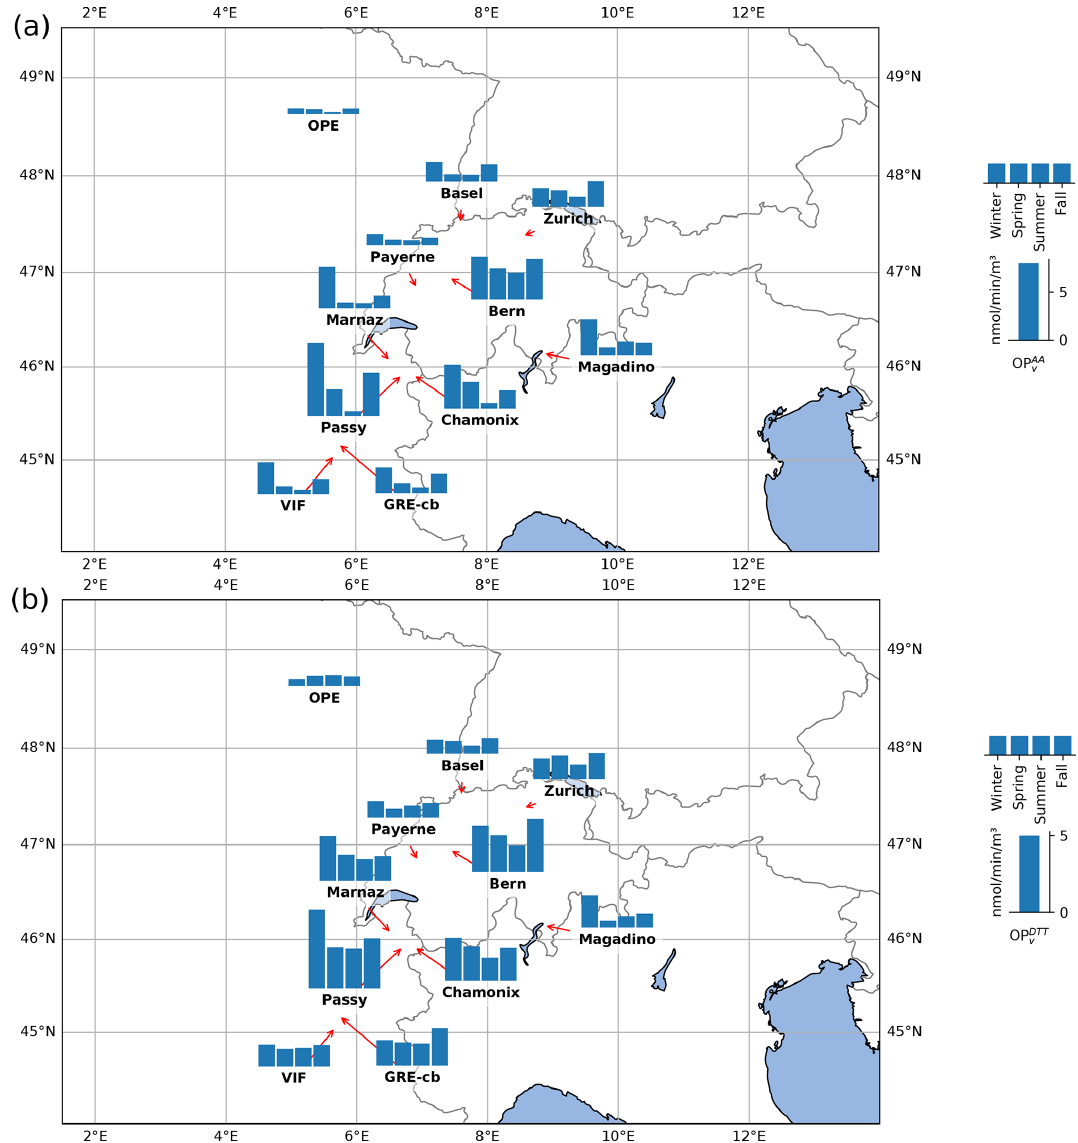
Figure 3. Seasonal OP AA v (a) and OP DTT v (b) PM 10 means for the five Swiss sites included in this analysis and the closest six French sites surrounding Switzerland. Data from the French sampling sites are from Weber et al.